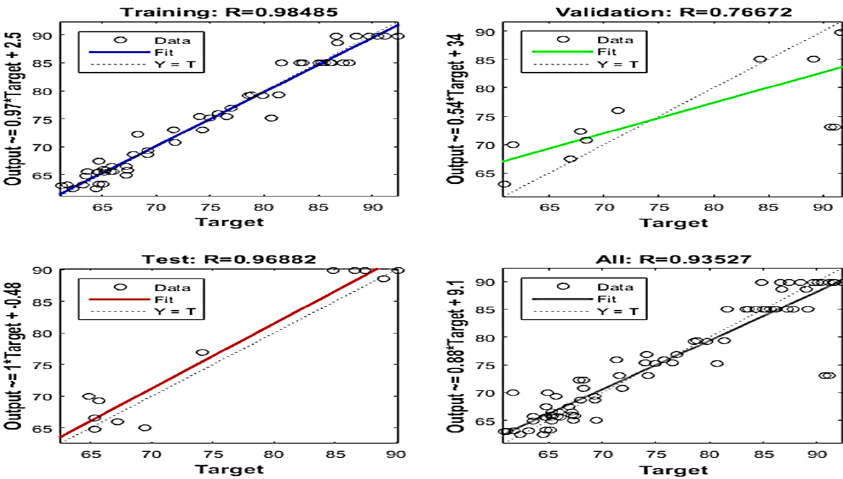
Figure 5 demonstrates the correlation between network outputs and network targets. The dashed line shows the perfect result, for example, outputs = targets, while the solid line represents the best fit linear regression. The training plot proves good fitness as the R-value is higher than 0.98. The validation and test plots show that the R-values are 0.76 and 0.96, respectively, indicating that some data points have poor fits.